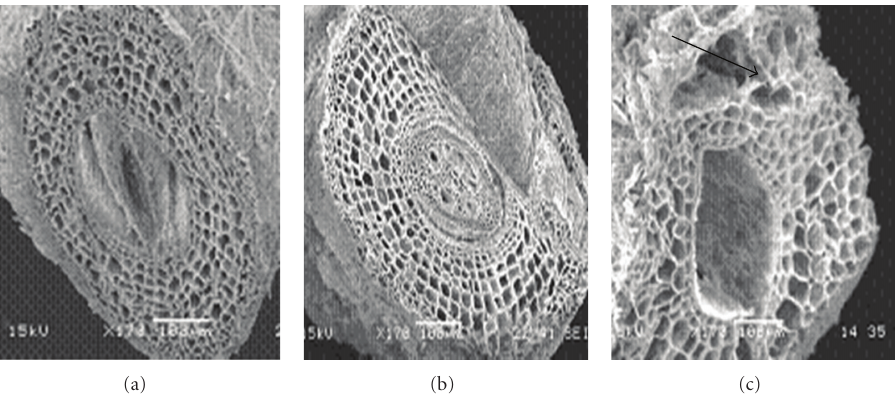
Figure 6: Scanning electron microscopy photographs showing root cortical tissue of C. dactylon “Tifdwarf” under (a) 0, (b) 24, and (c) 48dSm − 1 . The arrow indicates cell damage (c) compared to control (a).